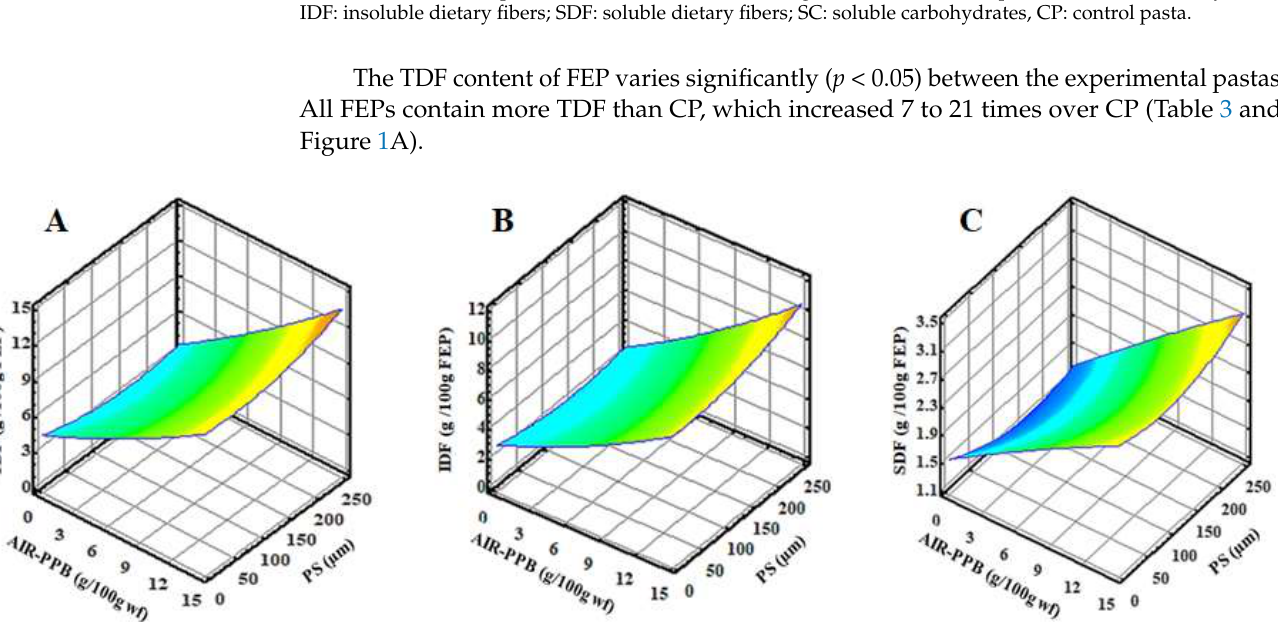
Figure 1. Response surface plots of the interaction of alcohol insoluble residue from potato peel byproduct (AIR-PPB) and particle size (PS) on ( A ) total dietary fibers (TDF) (g/100 g FEP), ( B ) insoluble dietary fibers (IDF) (g/100 g FEP), and ( C ) soluble dietary fibers (SDF) (g/100 g FEP) of FEP samples as compared to control pasta (CP) (0 AIR-PPB, 0 PS). FEP, fiber-enriched pasta. Depending on the source of the dietary fiber, fruit and vegetable byproducts may have varying amounts of insoluble and soluble fiber, which can affect their level of inclusion in direct-expanded products